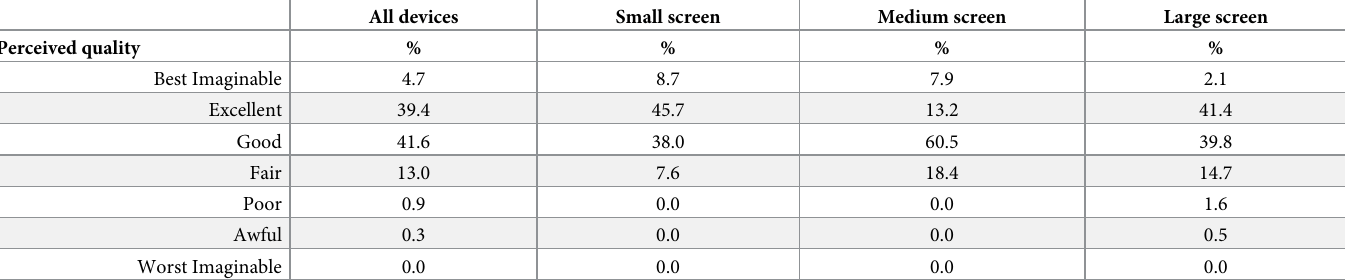
Table 2. Overall perceived quality of the eNutri app by participants (n = 322) of the EatWellUK study presented by small (n = 92), medium (n = 38) and large (n = 191) device screen